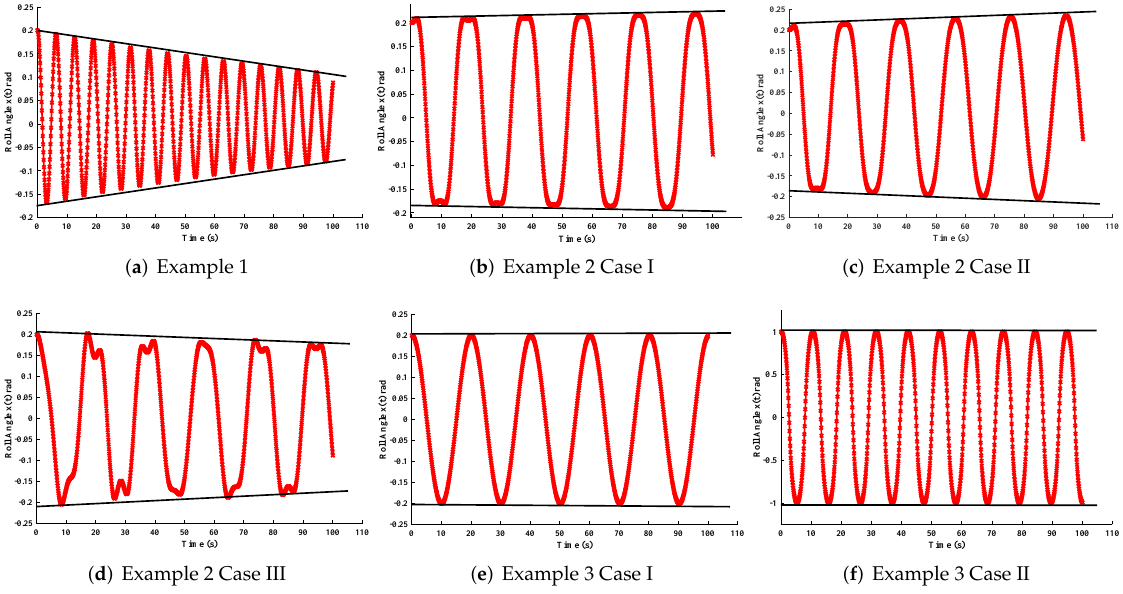
Figure 8. Roll angle decay curves for each